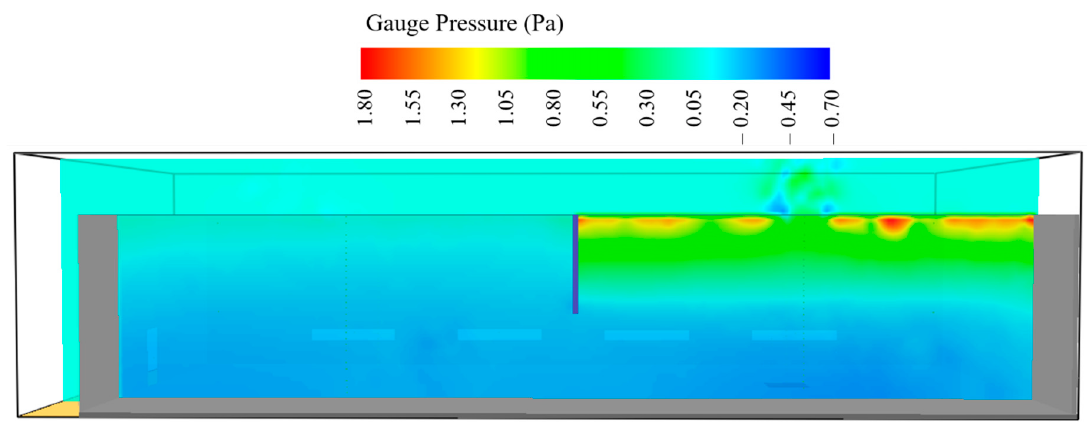
Energies 2020 , 13 , x FOR PEER REVIEW 21 of 27 Figure 14. Pressure field in a plane that crosses two exhaust vents (y = 3.75 m) at time t = 600 s (case 10).